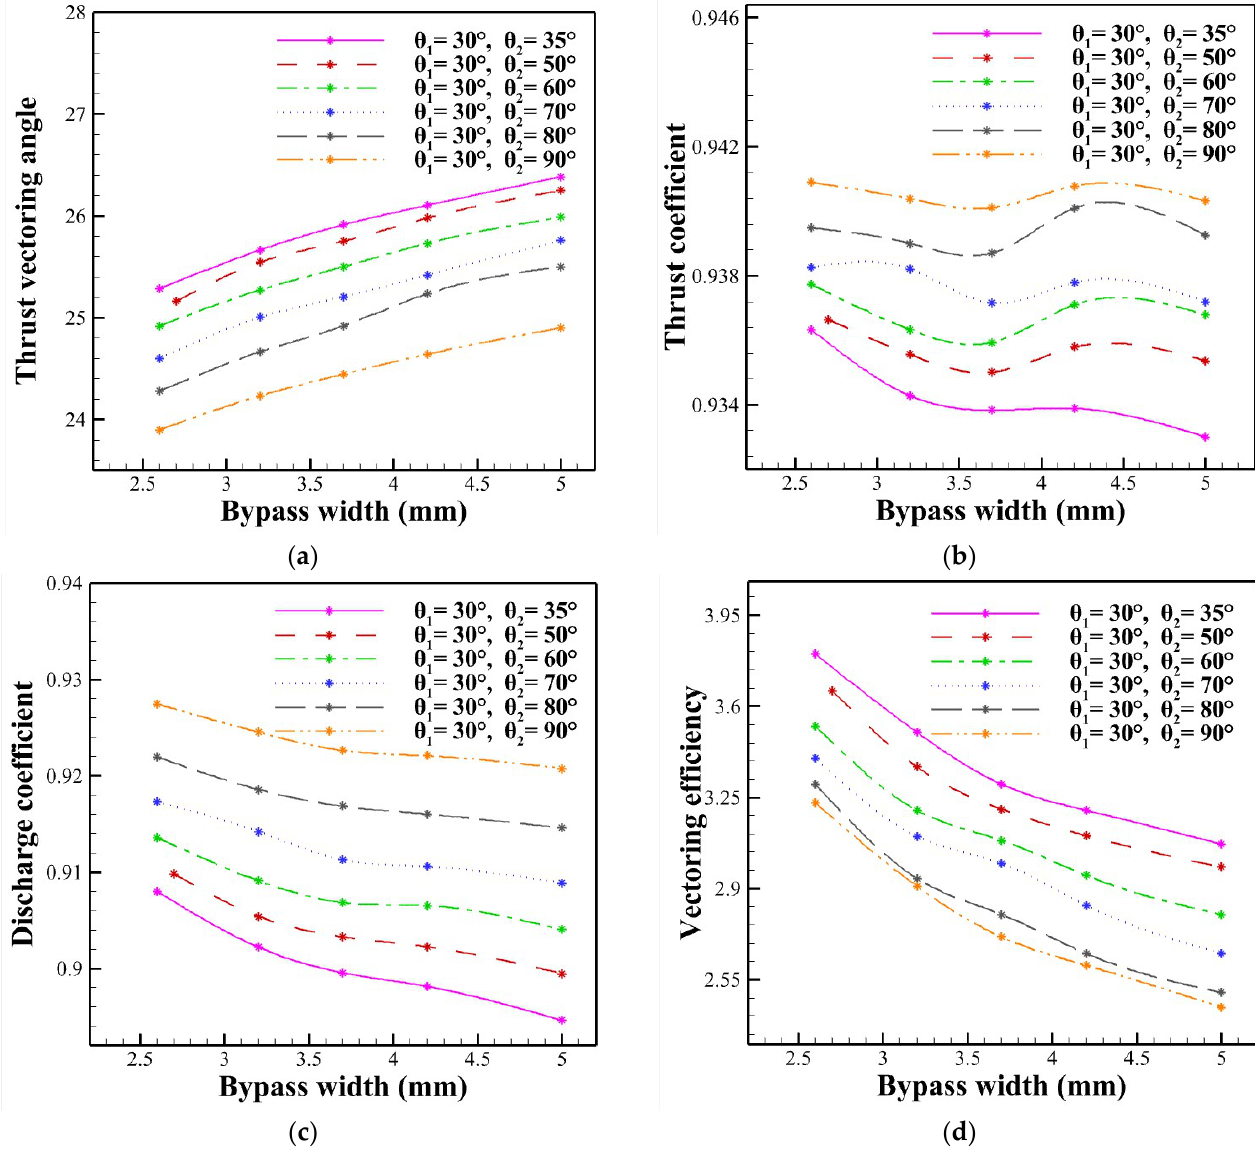
Figure 8. Variation of ( a ) vectoring angle, ( b ) thrust coefficient, ( c ) discharge coefficient, and ( d ) the vectoring efficiency for NPR = 3.